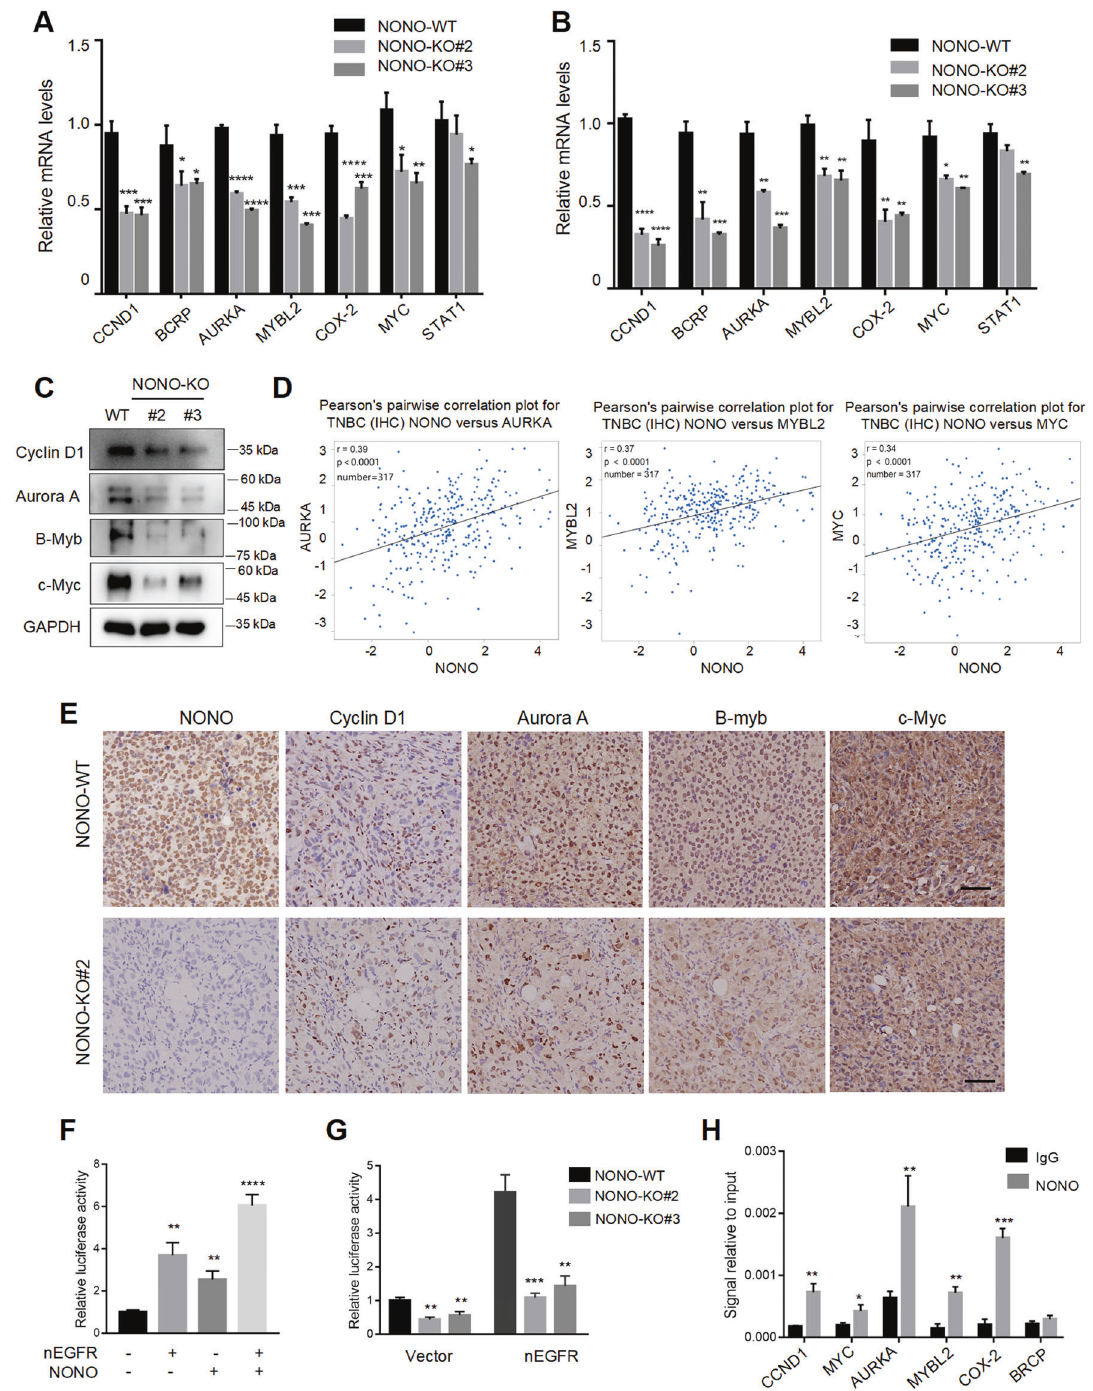
Fig. 4 NONO is required for the expression of nuclear EGFR targets. A , B The mRNA of nuclear EGFR targets (CCND1, BCRP, AURKA, MYBL2, COX-2, MYC, STAT1) were strongly declined upon NONO knockout in MDA-MB-468 ( A ) and MDA-MB-231 ( B ). C The protein of nuclear EGFR targets (Cyclin D1, Aurora A, B-Myb and c-Myc) were signi fi cantly decreased in MDA-MB-231 cells upon NONO knockout. D The expressional correlation between NONO and nuclear EGFR target genes (AURKA, MYBL2 and MYC) in the TNBC ( n = 317) were obtained from the bc- GenExMiner v4.5 database. The corresponding correlation plots were shown with Pearson ’ s coef fi cients. E The correlation between NONO and cylinD1, Aurora A, B-Myc, and c-Myc were shown in the representative IHC images of subcutaneous tumor tissue. Scale bar = 100 µm (×200). F Reporter assays were performed in MDA-MB-231 cells after being co-transfected with NONO and 3 × NLS EGFR plasmids for 48 h. Cells presented as a relative value with normalization against Renilla-Luc activity. nEGFR, nuclear EGFR. G Reporter assays performed in NONO knockout and control cells transfected with 3 × NLS EGFR or empty vector. nEGFR nuclear EGFR. H Cut&Run assay with NONO antibody was performed to verify the binding between NONO and promoters of nuclear EGFR targets in MDA-MB-468 cells. IgG as the negative control. Data are showed as the mean ± SD. The triplicate measurement results were repeated 3 times and the results were similar. * P < 0.05; ** P < 0.01; *** P < 0.01; **** P < 0.01 as indicated.